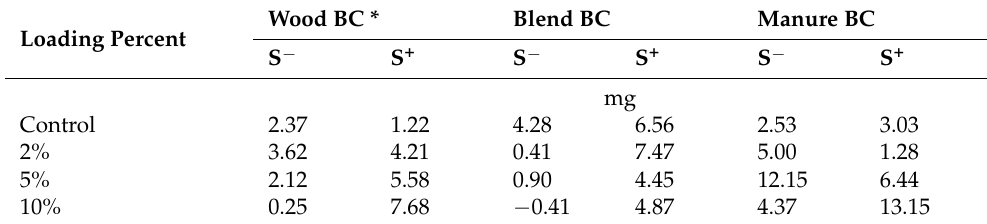
Table 14. Median total nitrogen content for Lolium multiflorum .